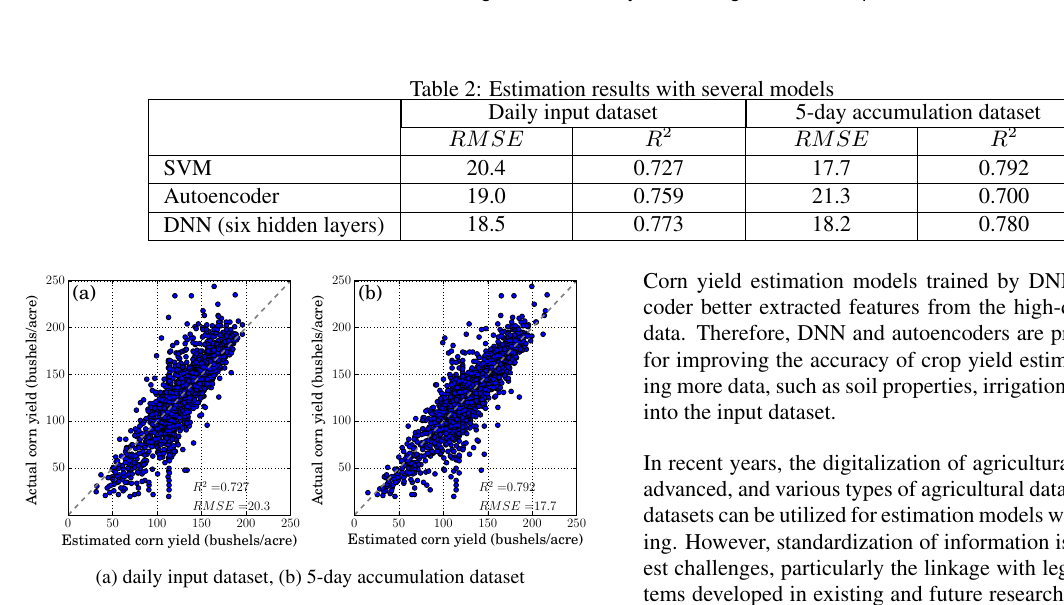
Figure 9: Corn yield estimation with SVM